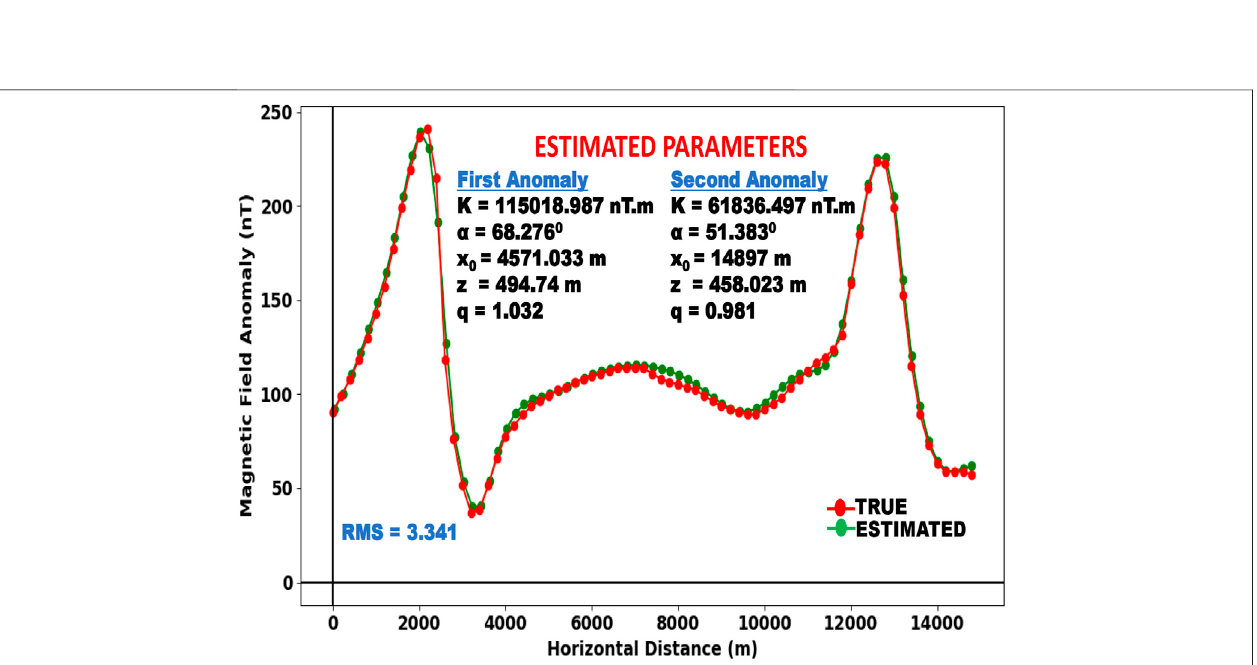
Frontiers in Earth Science |